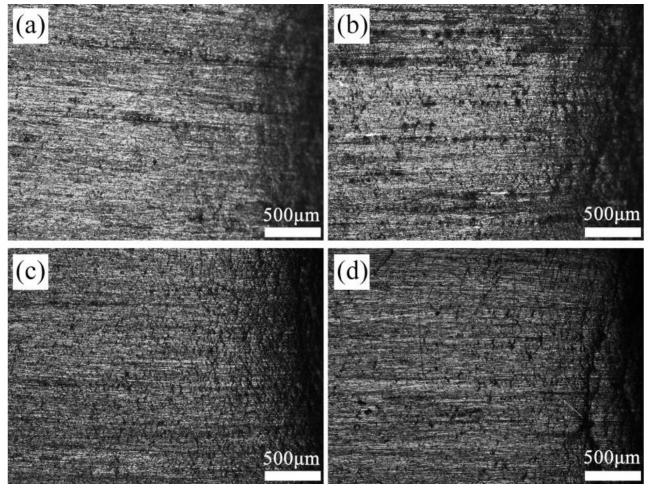
Figure 8. Surface morphologies of two aged alloys failed at different strain rate in 3.5% NaCl solution at pH 7: ( a ) 0.00Sc, 2 × 10 − 6 s − 1 ; ( b ) 0.00Sc, 1 × 10 − 6 s − 1 ; ( c ) 0.06Sc, 2 × 10 − 6 s − 1 ; ( d ) 0.06Sc, 1 × 10 − 6 s − 1